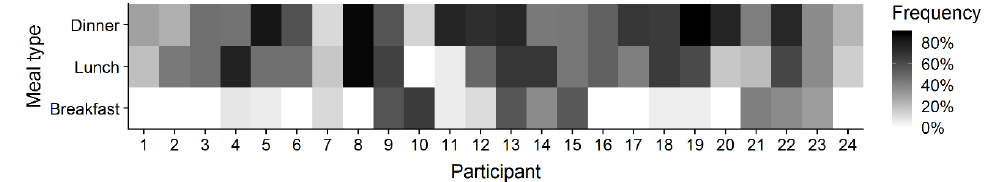
Table 2. Mean (SD) values of food intake weight and eating rate of recorded meals. Real-Life m